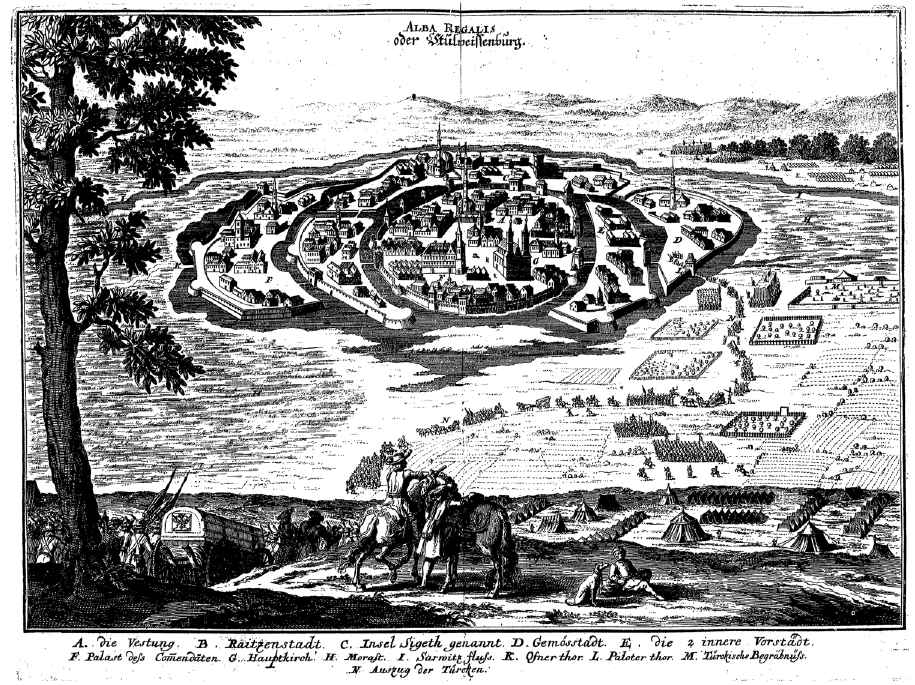
Figure 2. Székesfehérvár in the seventeenth century. An Early Modern depiction of the city before the modern drainage activity, shows that it was ordinarily surrounded by marshes. The image is from a 1667 print of Merian’s Theatrum Europaeum 27